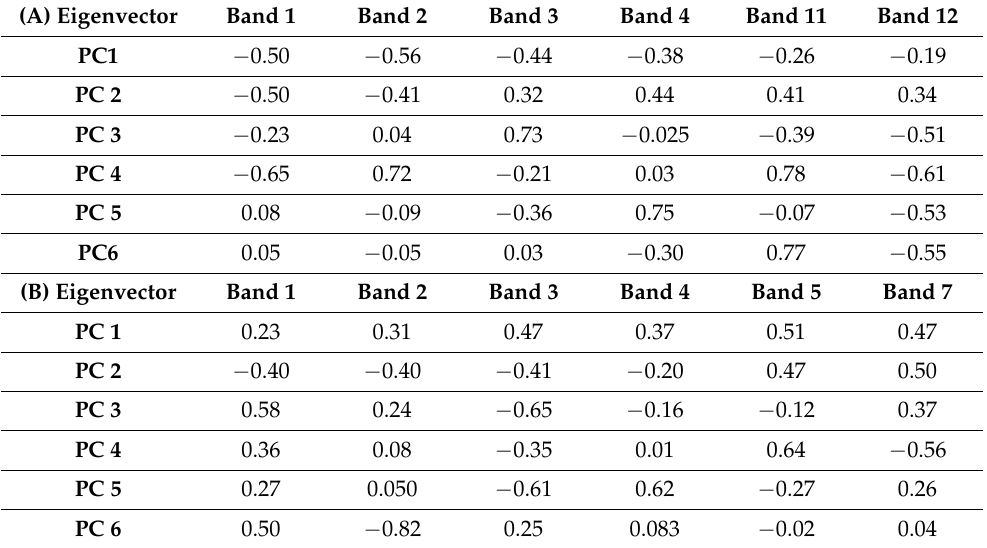
Table 1. (A) Eigenvector matrix for selected bands of Sentinel-2. (B) Eigenvector matrix for selected bands of